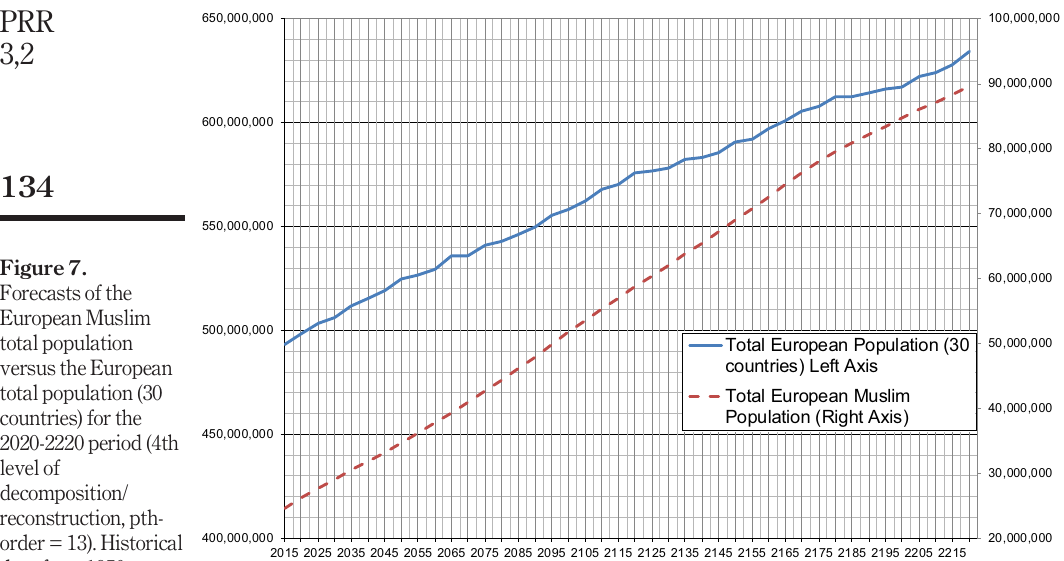
(i.e. no de-noising and no decomposition of the time series). We use the Root Mean Error Square criteria (forecasts versus historical data) to compute the error of forecasting.